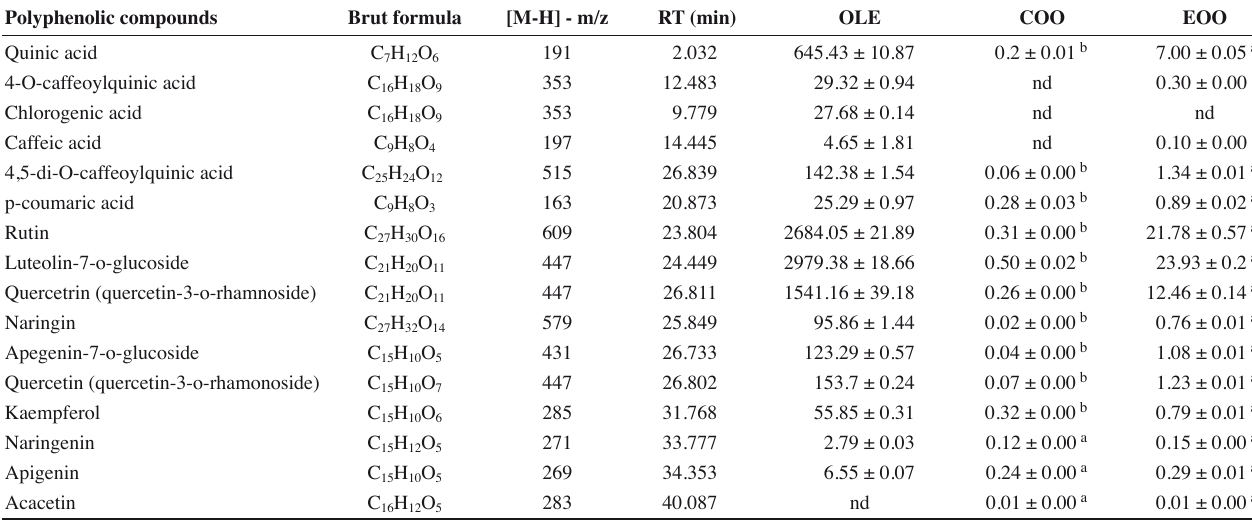
Tab. 3: Polyphenolic compounds of olive oils and oleaster leaf extracts. Polyphenolic compounds